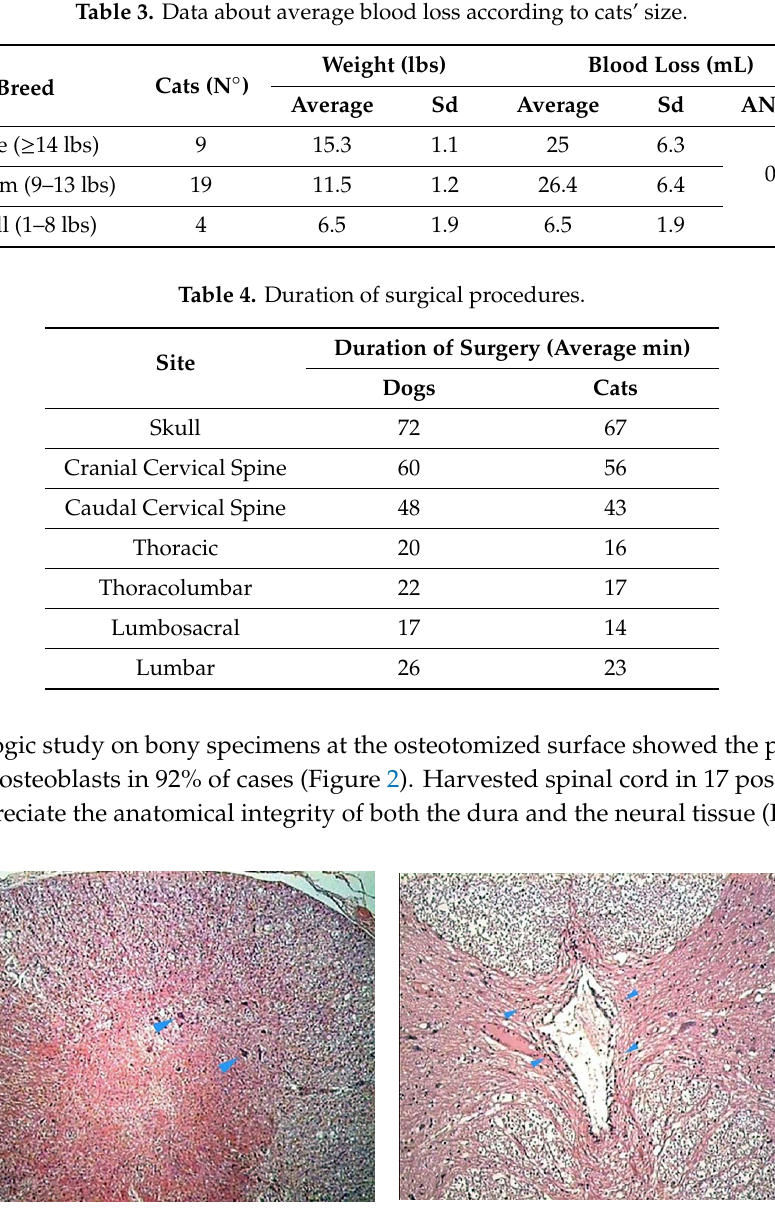
Table 3. Data about average blood loss according to cats’ size.